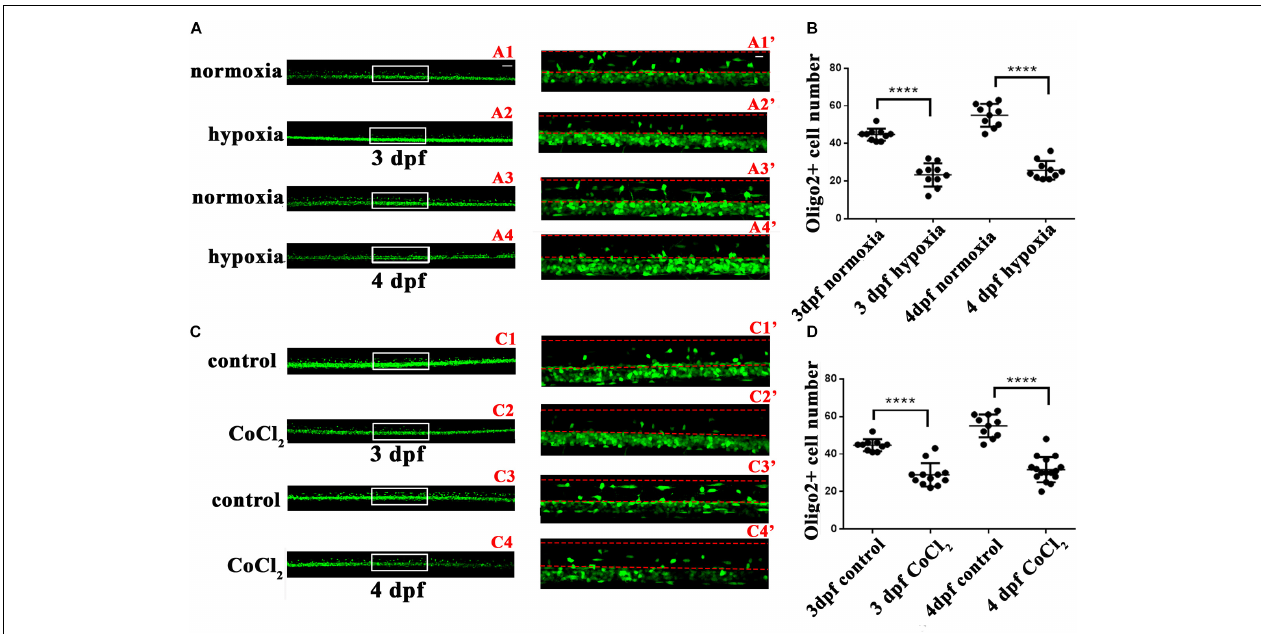
FIGURE 2 | Hypoxia and CoCl 2 · 6H 2 O suppressed OPC migration to the dorsal area. The number of dorsally migrated spinal cord olig2 + cells was counted in Tg ( olig2 : EGFP) zebrafish using a 10 × objective lens on a FV1000 microscope (Olympus, Tokyo, Japan). (A,B) The number of dorsally migrated olig2 + cells decreased under hypoxia at 3 and 4 dpf. A1 (cid:48) , A2 (cid:48) , A3 (cid:48) , and A4 (cid:48) are the magnified pictures of the white boxes in A1, A2, A3, and A4. Two-way ANOVA, P < 0.0001: Student’s two-tailed t -test. Significantly more cells were dorsally migrated in 3-dpf normoxic larvae as compared to 3-dpf hypoxic larvae ( n = 10; P < 0.0001). Significantly more cells were dorsally migrated in 4-dpf normoxic larvae as compared to 4-dpf hypoxic larvae ( n = 10; P < 0.0001). (C,D) The number of dorsally migrated spinal cord olig2 + cells in 3- and 4-dpf larvae decreased after CoCl 2 · 6H 2 O exposure. C1 (cid:48) , C2 (cid:48) , C3 (cid:48) , and C4 (cid:48) are the magnified pictures of the white boxes in C1, C2, C3, and C4. Two-way ANOVA, P < 0.0001: Student’s two-tailed t -test. Significantly more cells were dorsally migrated in 3-dpf normoxic larvae as compared to 3-dpf hypoxic larvae ( n = 10; P < 0.0001). Significantly more cells were dorsally migrated in 4-dpf normoxic larvae as compared to 4-dpf hypoxic larvae ( n = 10; P < 0.0001). The dashed line indicates the dorsal spinal cord. Scale bars: A1–A4 and C1–C4, 50 µ m; A1 (cid:48) –A4 (cid:48) , and C1 (cid:48) –C4 (cid:48) , 10 µ m. ∗ P < 0.05; ∗∗ P < 0.01; ∗∗∗ P < 0.001. Error bars represent